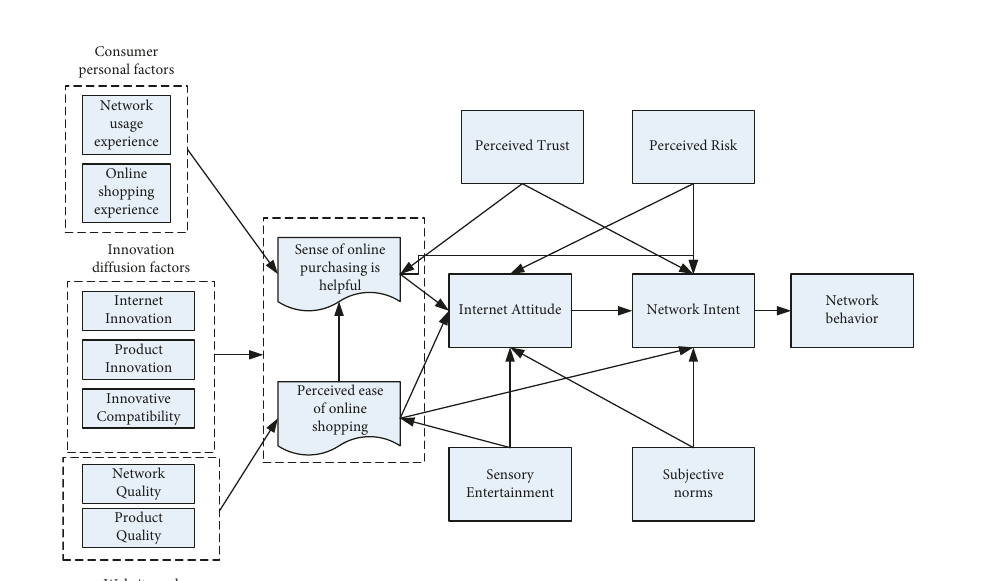
Figure 4: Extended model of consumer online shopping